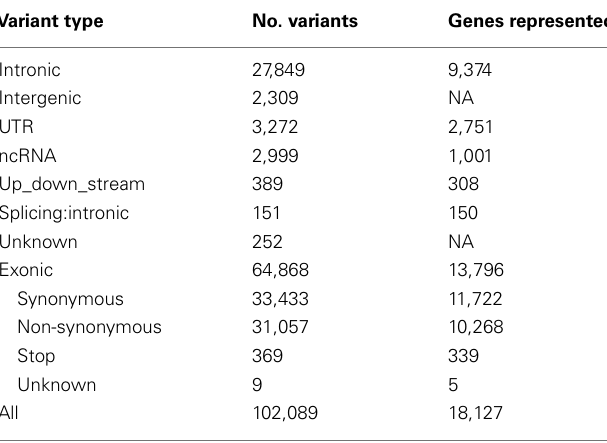
Table 4 | Genetic variants found byWES and annotated